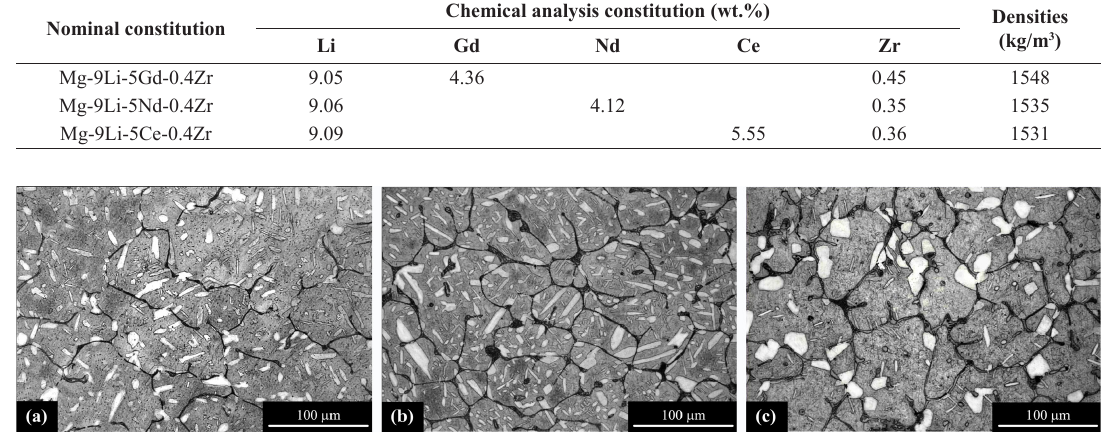
Figure 1. Microstructures of as-cast (a) Gd-containing, (b) Nd-containing and (c) Ce-containing alloys.